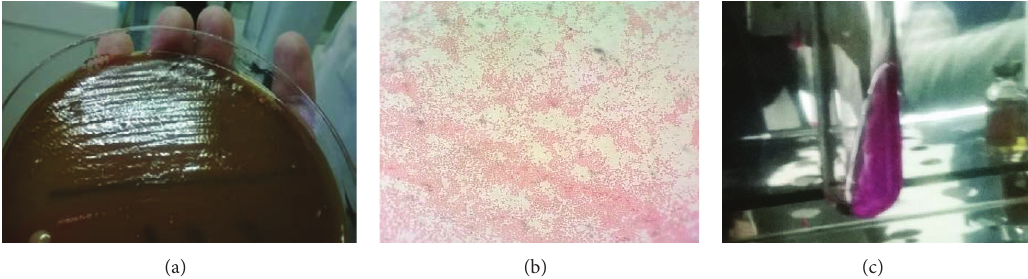
Figure 3: Brucella colonies on blood agar (a); Gram stains of colonies revealing Gram-negative coccobacilli (b); positive urease test